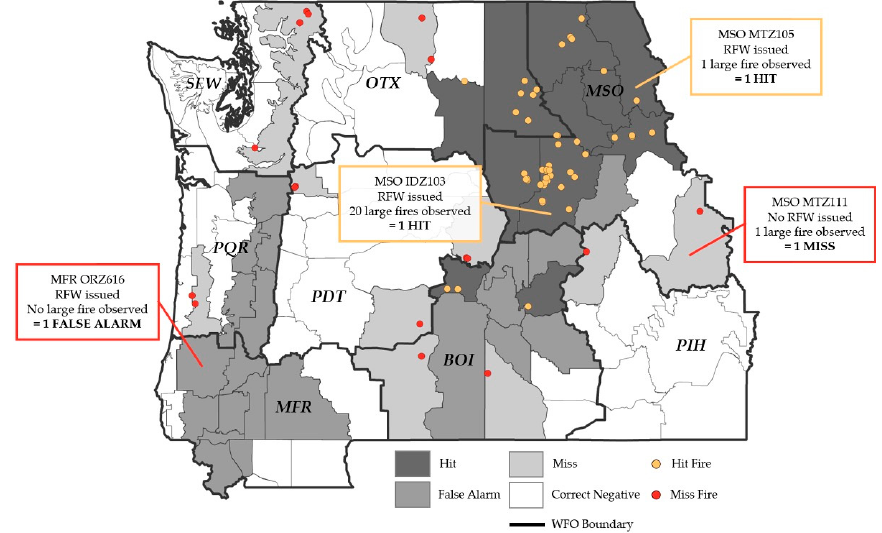
Figure 3. An example of the RFW and large fire day classification scheme pairing RFWs issued for 10 August 2015 and new large fires from 10–11 August 2015. Thirty-two RFWs were issued, resulting in 11 hits, 11 misses, and 21 false alarms across the study area.